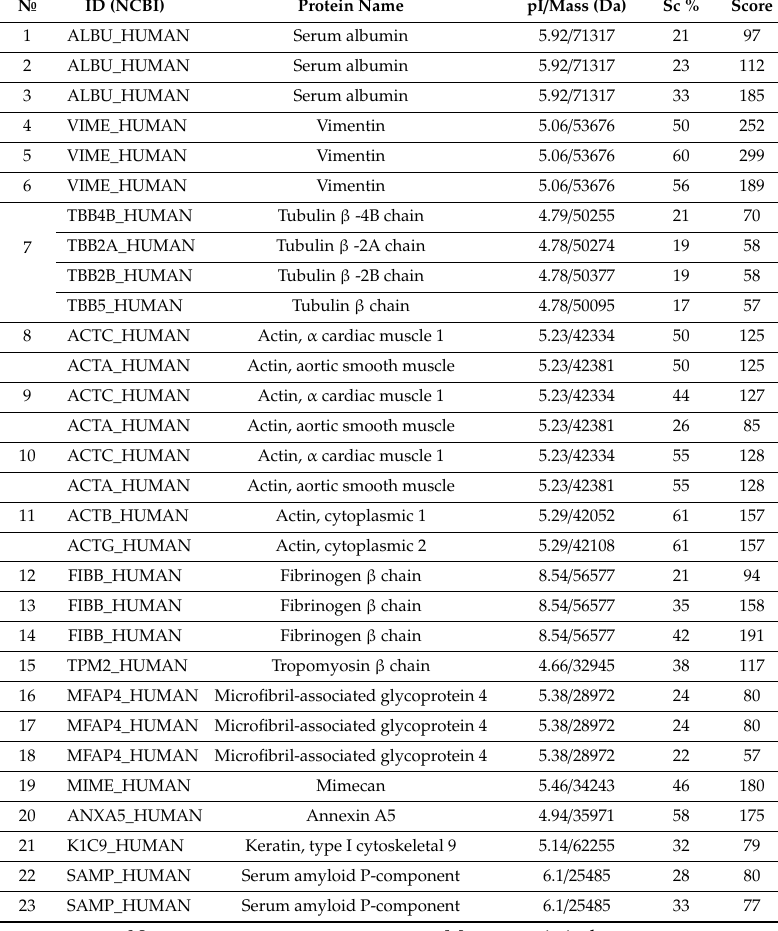
Table 1. Mass-spectrometric identification of proteins in the pools of homogenates of atherosclerotic plaques. № ID (NCBI) Protein Name pI / Mass